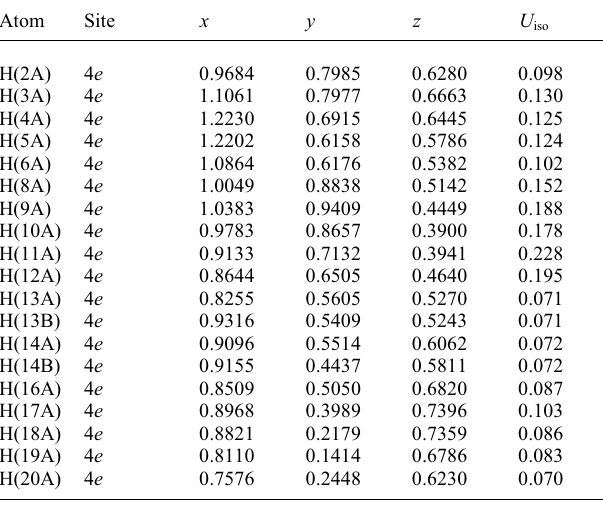
Table 2. Atomic coordinates and displacement parameters (in Å 2 )